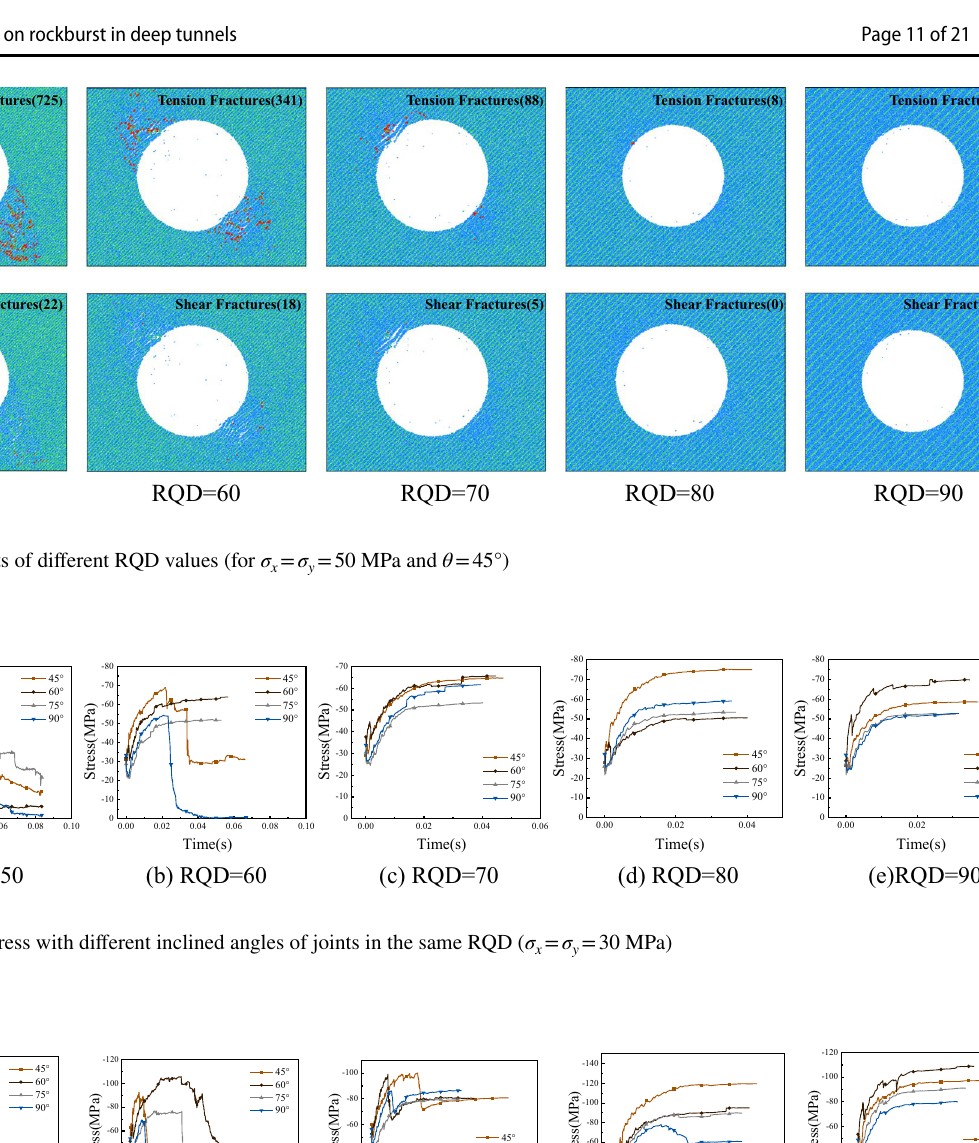
(a)RQD=50 Fig. 20 Tangential stress with different inclined angles of joints in the same RQD ( σ